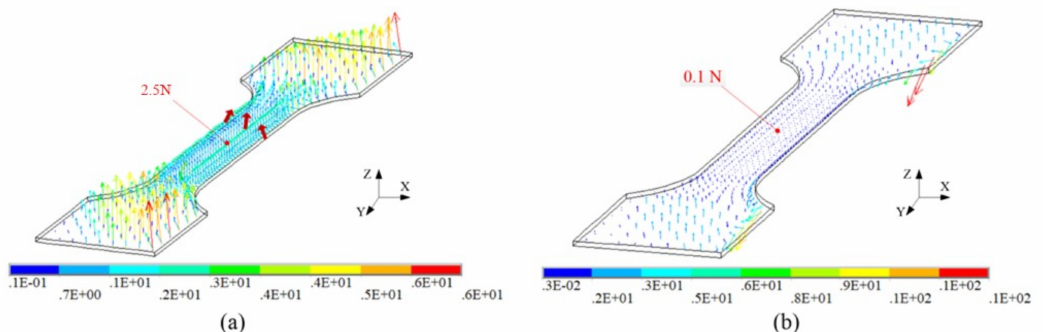
Figure 6. Magnetic force distribution on the sample at 20 µ s: ( a ) using the conductive die and ( b ) using the nonconductive